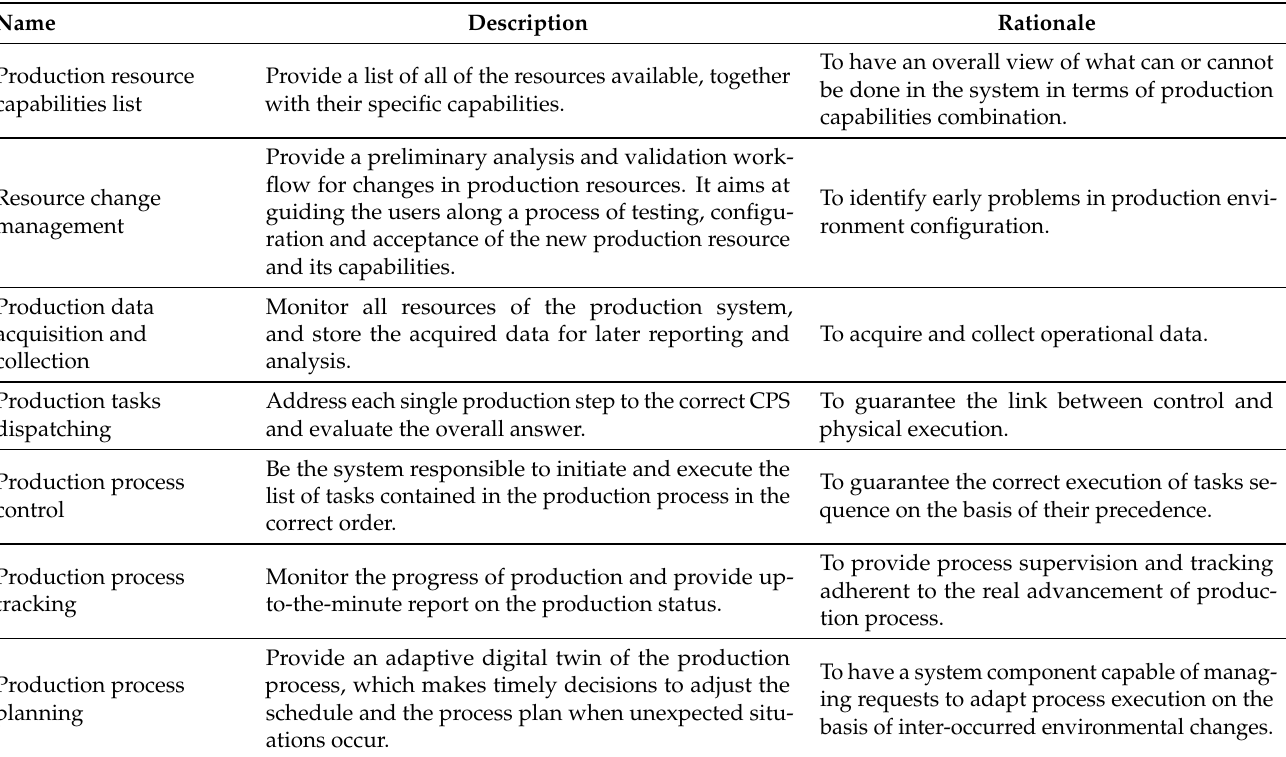
Table 2. List of major functional requirements of the